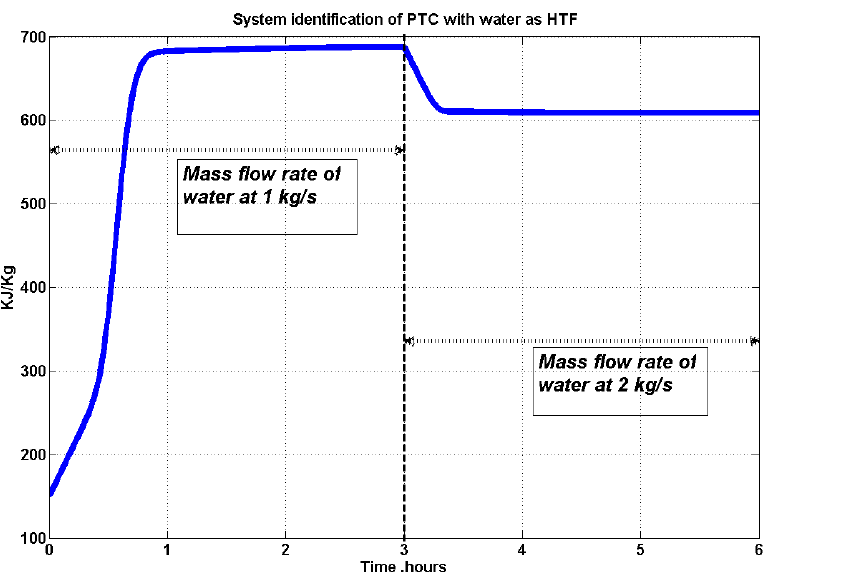
Figure 6. System identification of PTC for water as HTF.